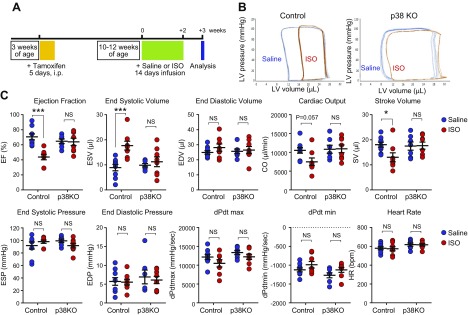
Effect of fibroblast-specific p38α KO on ISO-induced cardiac dysfunction. A) Timeline for chronic β-adrenergic receptor activation model of cardiac hypertrophy. B) Individual representative PV loops obtained from control and fibroblast-specific p38α KO mice following infusion with either saline (control, blue) or ISO (red). C) PV conductance catheter data. Individual data and means ± sem are shown. Group sizes: control saline (n = 9), control ISO (n = 8), KO saline (n = 7), and KO ISO (n = 8). EDV, end diastolic volume; CO, cardiac output; SV, stroke volume. ANOVA with Sĭdák post hoc test: *P < 0.05, ***P < 0.001. NS, not significant.